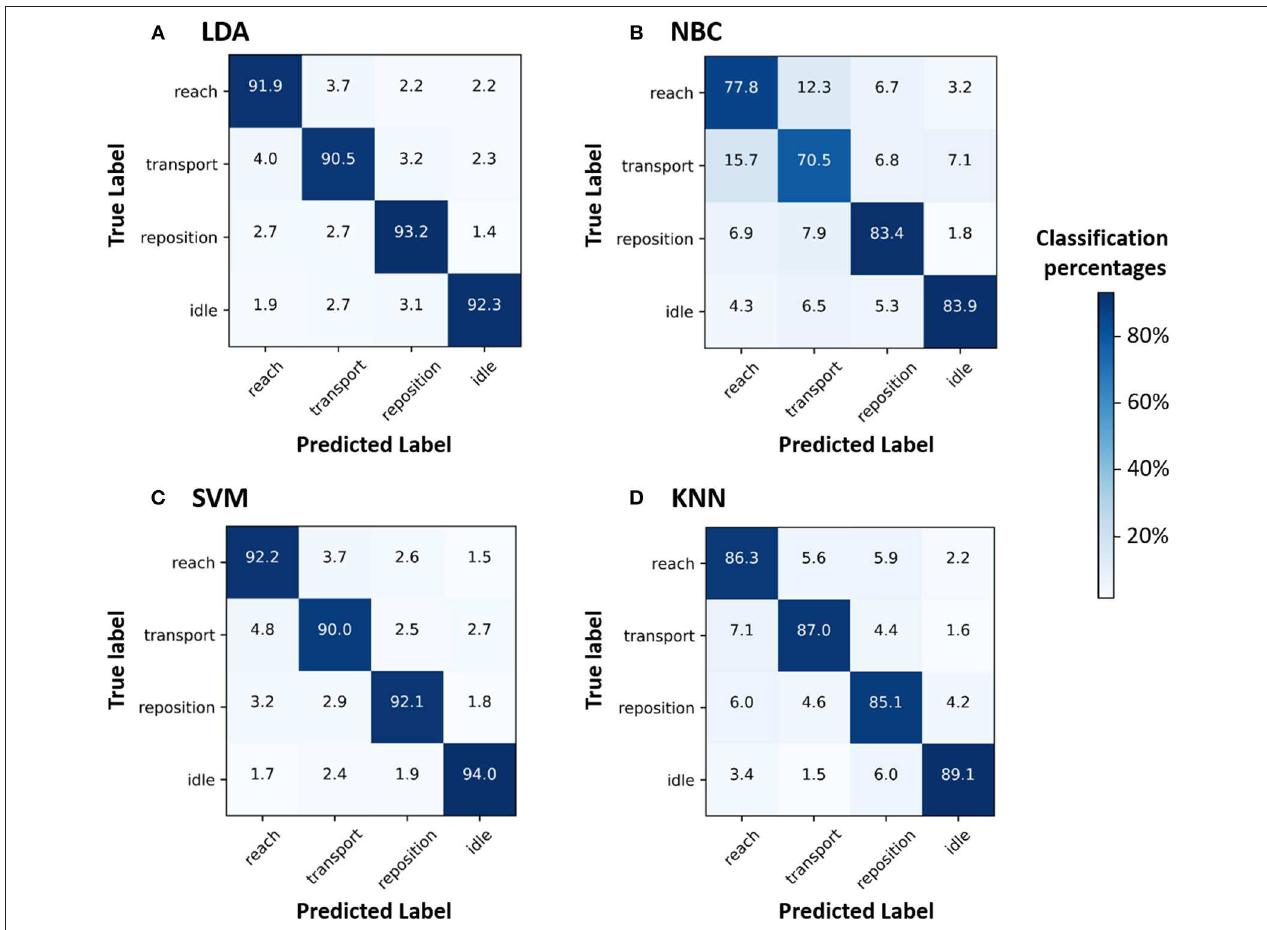
FIGURE 2 | Confusion matrices (CMs) for the ML algorithms (A) LDA, (B) NBC, (C) SVM, and (D) KNN. CMs help visualize where ML algorithms are performing well (successful classification) or becoming confused (misclassification). Numbers in the diagonal cells represent the percentage of samples belonging to a class that were correctly classified by the ML algorithm. Numbers in the non-diagonal cells represent the percentage of samples belonging to a class (e.g., reach ) that were classified by the ML algorithm as another class (e.g., transport ). CMs with high values for diagonal cells indicate accurate classifications. In contrast, CMs with high values for non-diagonal cells indicate high misclassifications. The color bar indicates the percentage of primitives from a given class that has been classified as the same class (diagonal cells) or another class (non-diagonal cells). LDA and SVM accurately classified all four primitives, closely followed by KNN. NBC performed inadequately and became confused between reaches and transports